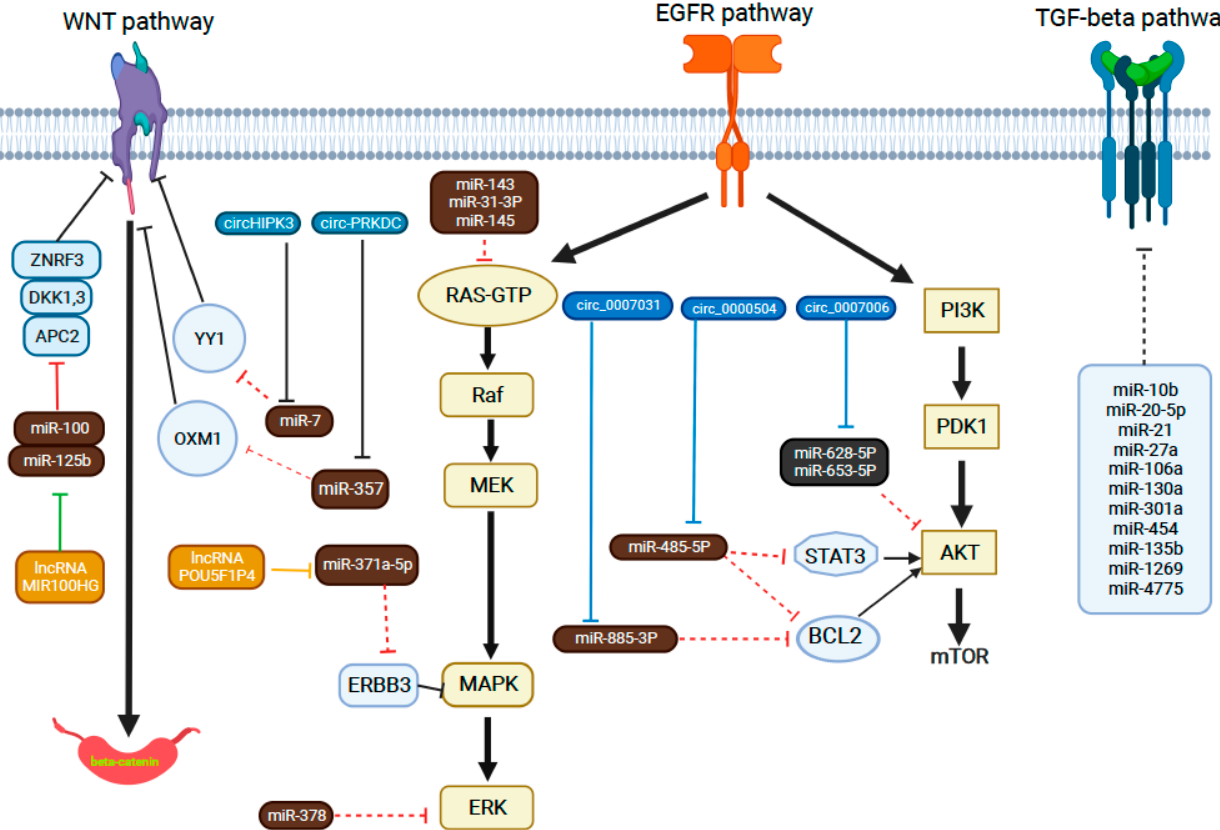
Figure 5. Mechanisms by which ncRNAs (circRNAs, lncRNAs, miRNAs) target the main pathways involved in the pathogenesis of CRC (created with Biorender.com).